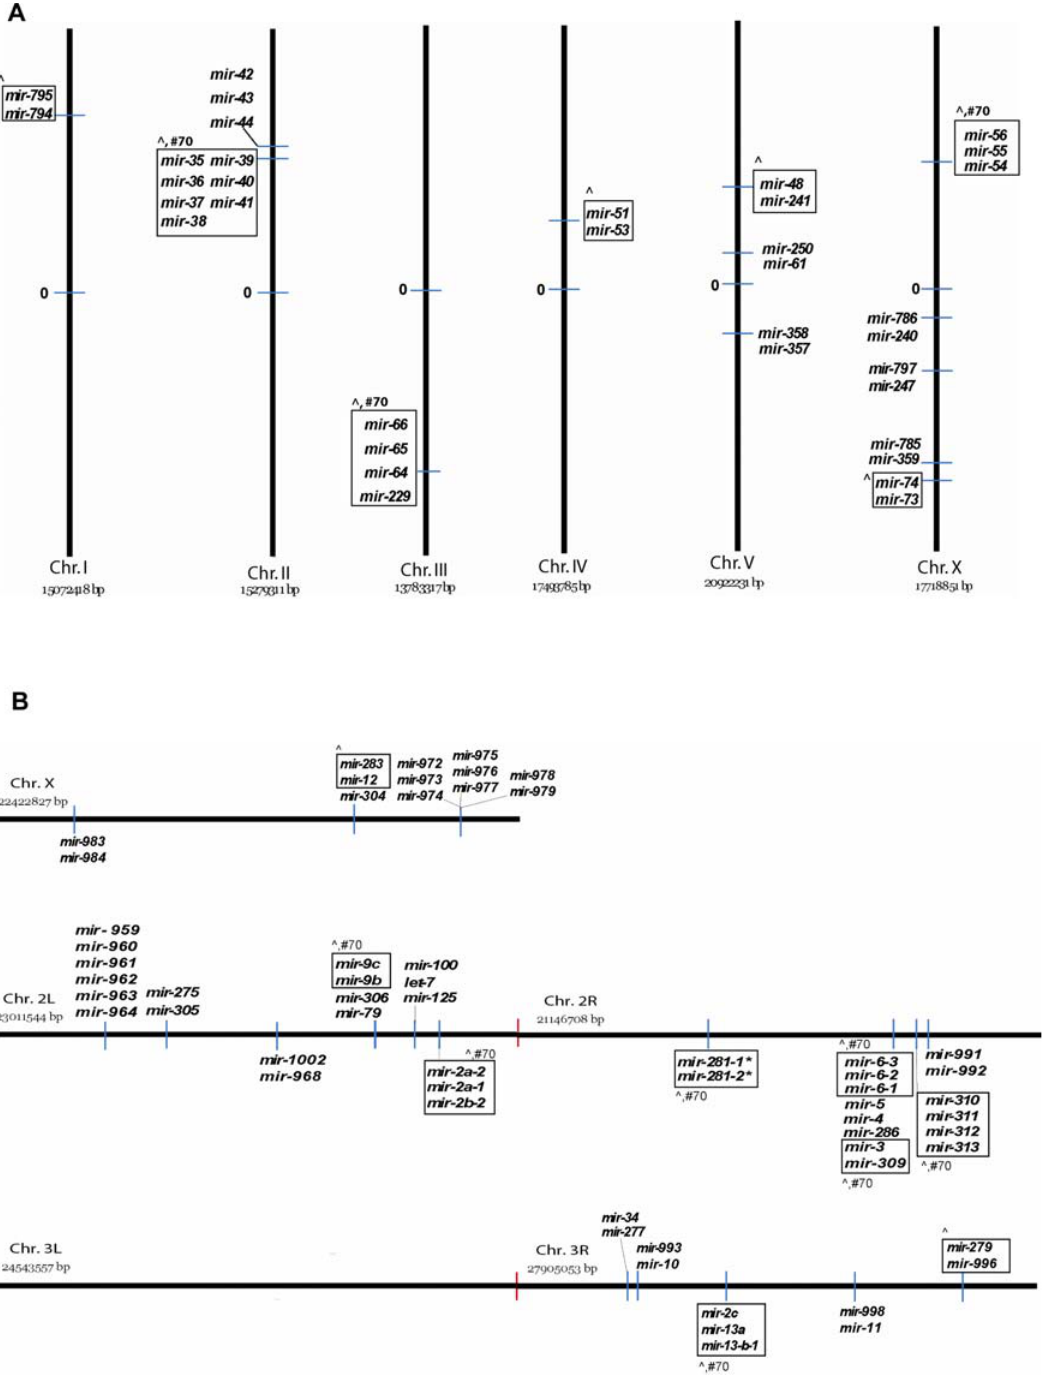
Figure 1. Clusters of mir genes in the C.elegans and D.melanogaster genomes. 35 of the 137 C. elegans mir genes (the 137 genes produce 139 miRNA forms) (A) and 60 of the 152 D. melanogaster mir genes (B) are situated within 2 Kb of each other on one of their chromosomes (6 chromosomes in C. elegans : Chr. I–V, Chr. X; 4 pairs of chromosomes in D. melanogaster : Chr. 2–4, X/Y). , 63% clustered mir genes in the C. elegans genome and , 38% in the D. melanogaster genome are related in sequence. Bounding boxes highlight clustered mir genes of conserved sequences at the 5 9 end (^) and/or over full length ( # 70 indicates $ 70% similarity) (see Tables 1, 2 and Datasets S1, S2, S4 and S5 for details). mir genes on the left or above chromosomes are found in the Watson strand whereas those on the right or below are located in the Crick strand. The physical centers of C. elegans chromosomes are indicated by ‘‘0’’.